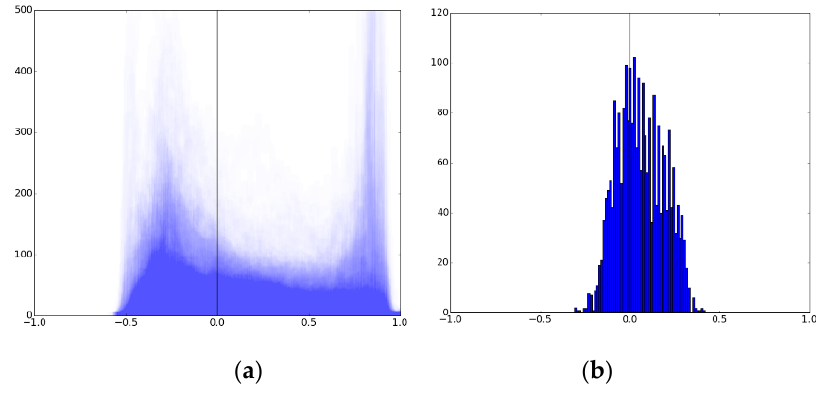
Figure 10. Histograms of MNDWI values within 15 m of detected edges ( a ) and a histogram of detected